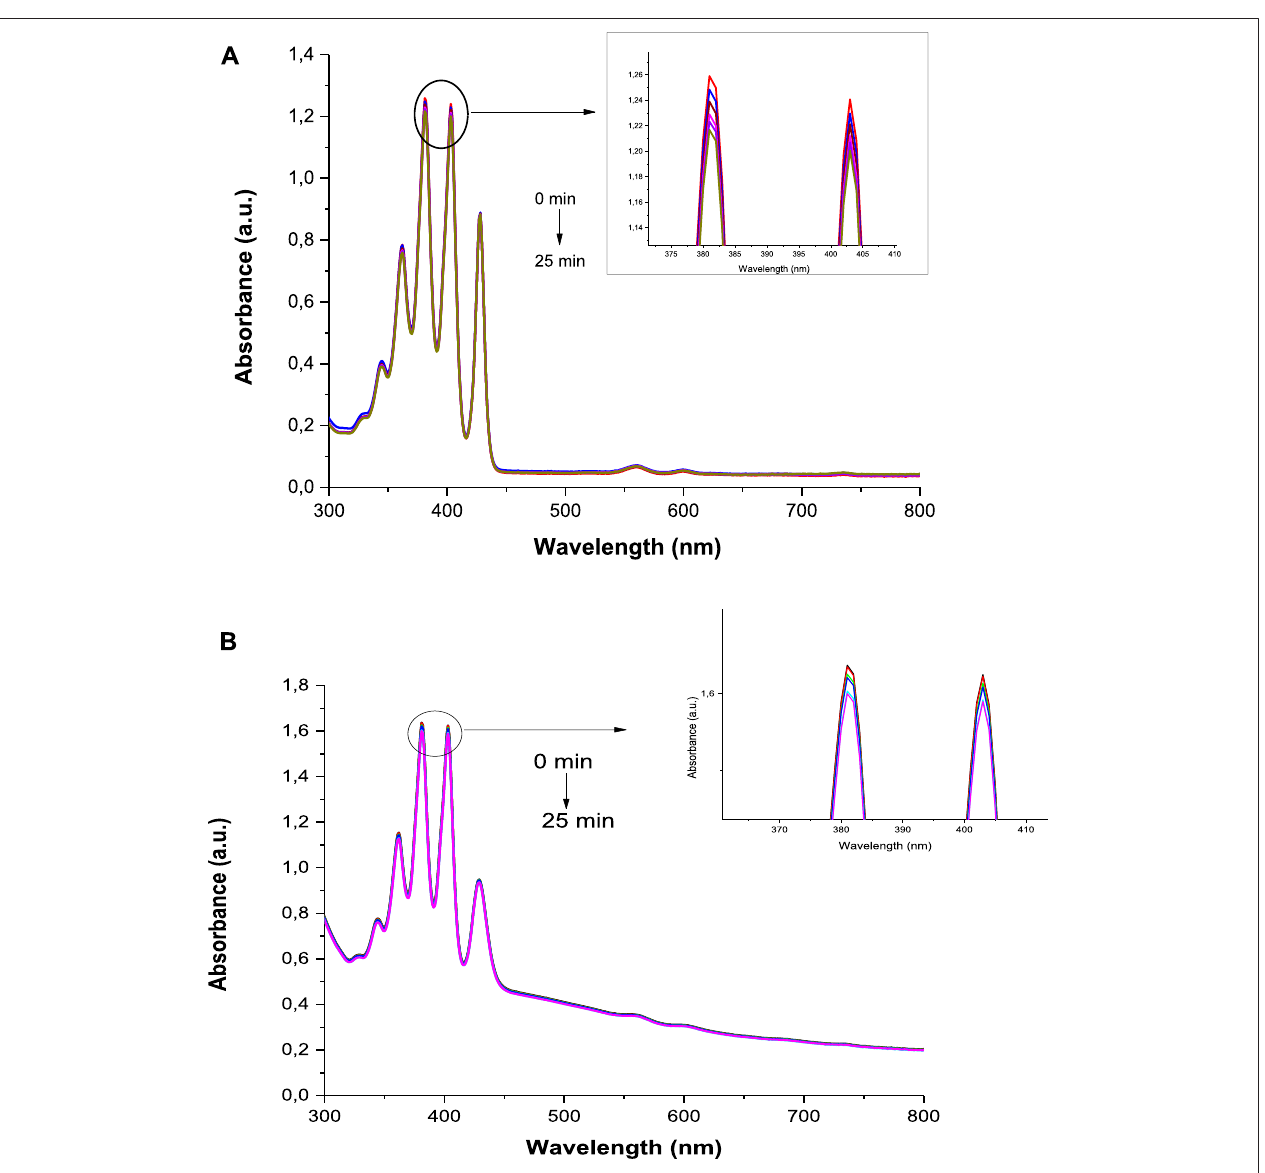
FIGURE 8 | Photobleaching of DMA in DMSO in the presence of (A) 3 and (B) 3 -DNDs@Ag as examples.